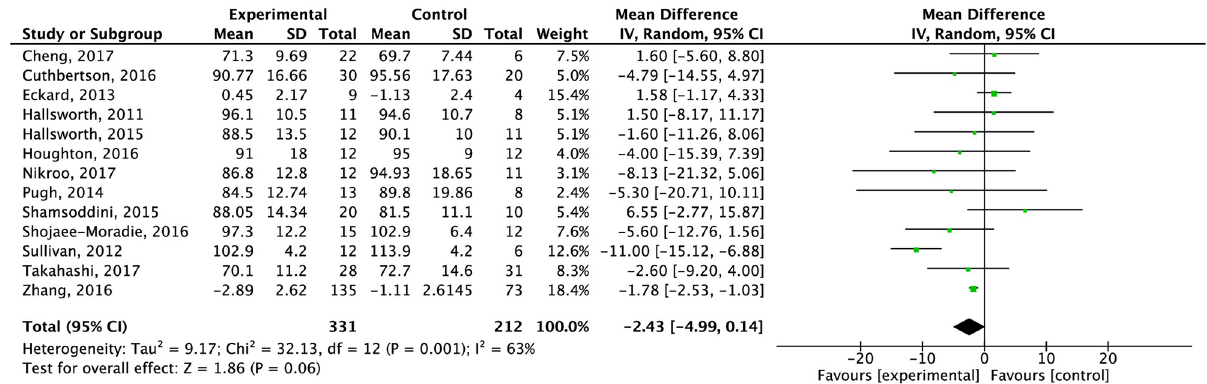
Fig 2. Effect of exercise alone compared to the control group in body